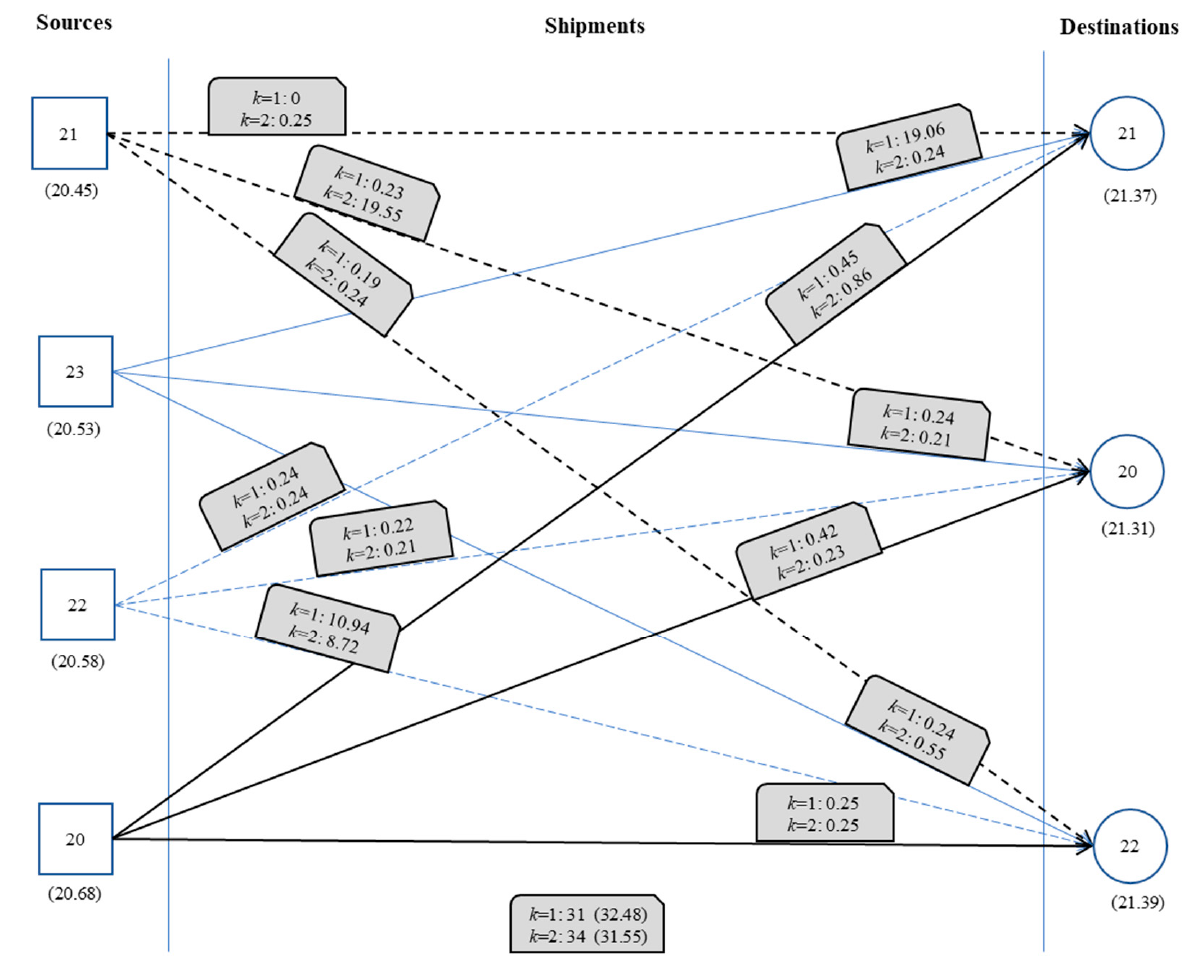
Figure 1. Optimal solution for MOSSTP using the GCM. Table 5. Optimal solutions for four stochastic models using the FGP